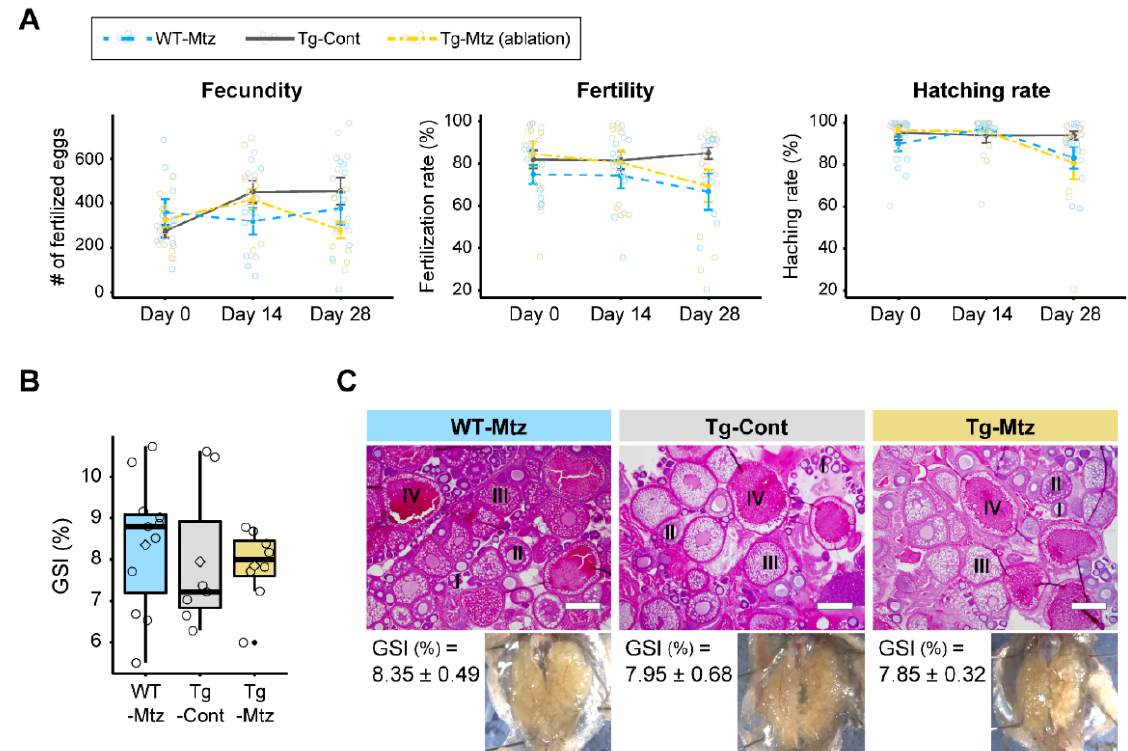
Figure 3. GnRH3 neuron ‐ ablated females exhibit normal fertility. ( A ) Number of fertilized eggs per spawn (fecundity), percentage of fertilized eggs (fertility), and hatching rate from the experimental females paired with WT males before treatment, and at 28 days of treatment. ( B ) Gonadosomatic index (GSI) ( n = 7–11). ( C ) Representative ovarian sections stained with hematoxylin and eosin. Scale bars, 500 μ m. Bottom panels, images of the intact ovaries with the corresponding GSI (mean ± SEM) adjacent to each image. Scale bars, 1 mm. WT ‐ Mtz, WT siblings treated with 2 mM metronidazole (Mtz); Tg ‐ Cont, Tg(gnrh3:Gal4ff; UAS:nfsb ‐ mCherry) treated with vehicle; Tg ‐ Mtz, Tg(gnrh3:Gal4ff; UAS:nfsb ‐ mCherry) treated with 2 mM Mtz. p > 0.05.